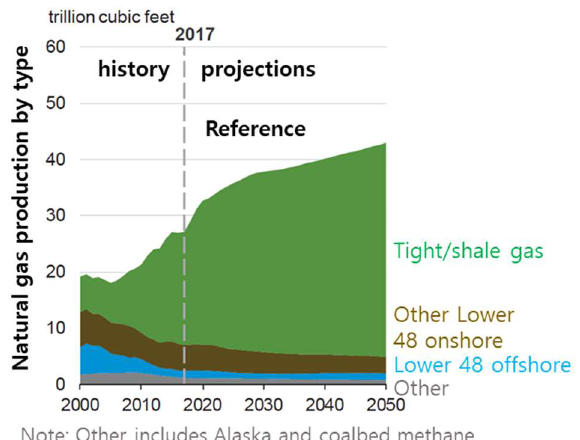
Figure 1. Natural gas production by type, 2000–2050 (trillion cubic feet) [1,4]. Reproduced from [1,4], EIA: 2018, Stevens: 2012.